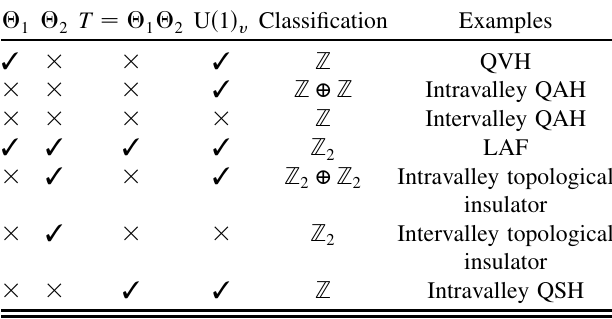
a The classification for the superconductors is identical to that for the